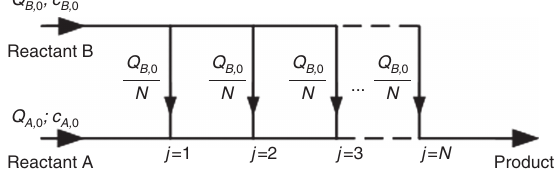
Figure 2 Simplified scheme of the multi-injection reactor